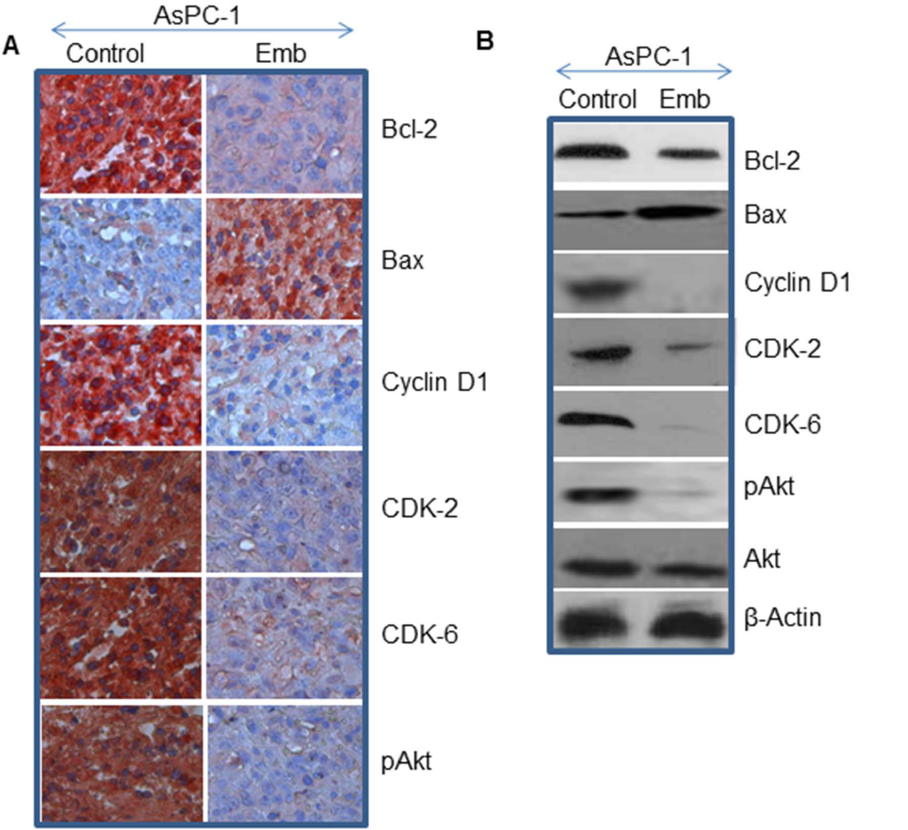
Figure 5. Effects of embelin on the expression of Bcl-2 family members, cell cycle-related proteins and Akt in tumor tissues. (A), Expression of Bcl-2, Bax, Cyclin D1, CDK2, CDK6 and phospho-Akt. Immunohistochemistry was performed as described in material and methods. (B), Western blot analysis was performed to measure the expression of Bcl-2, Bax, Cyclin D1, CDK-2, CDK-6, p-AKT (Ser473), and AKT. The b -actin was used as a loading